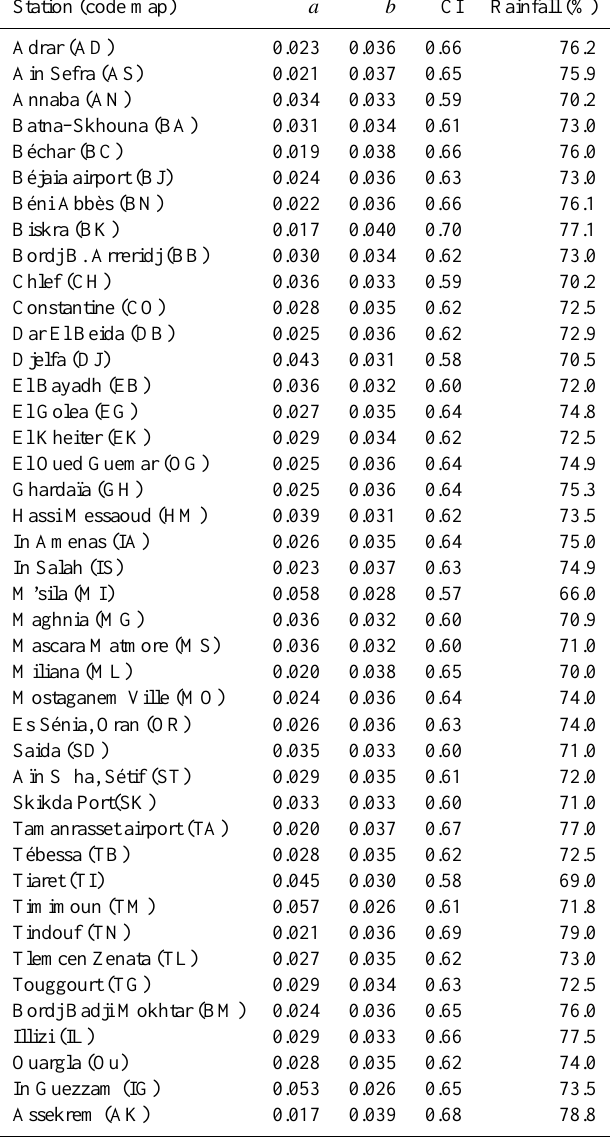
Table 3. Values of constants a and b of the exponential curves given by Eq. (1). The concentration index (CI) and the rainfall percent- age contributed by 25% of the rainiest days for 42 weather stations across Algeria (during the period of